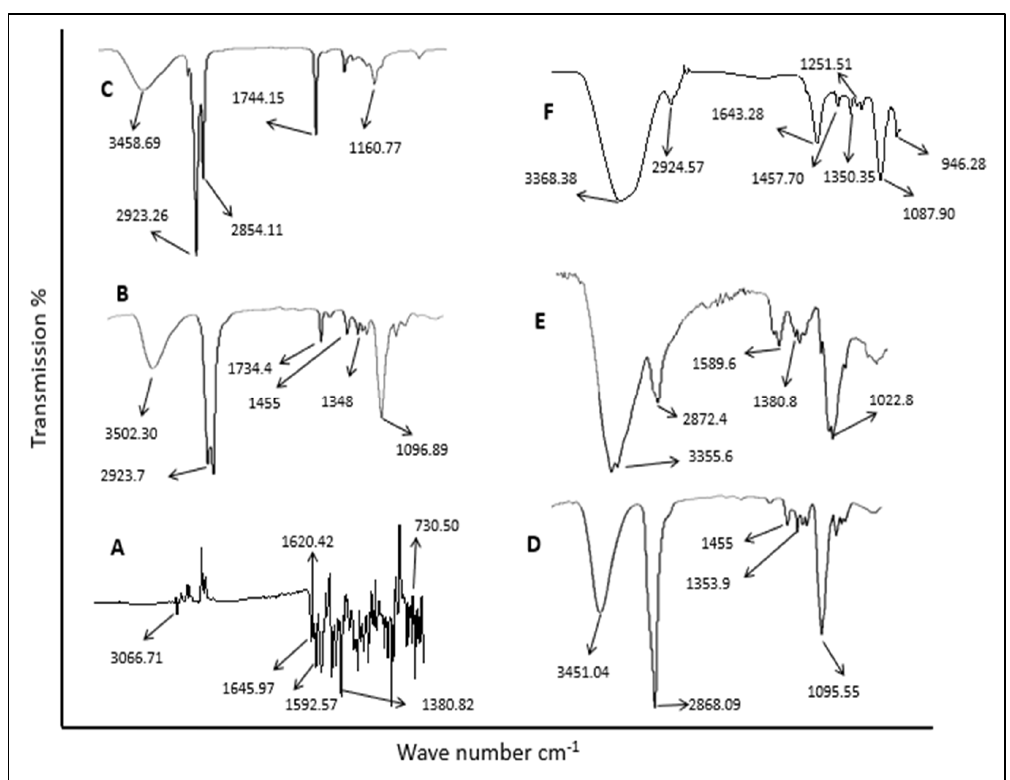
Figure 1. ATR-FTIR spectra of ( A ) pure drug, ( B ) Tween 80, ( C ) almond oil, ( D ) PEG 400 ( E ) chitosan, and ( F ) chitosan-decorated LRX-NE.